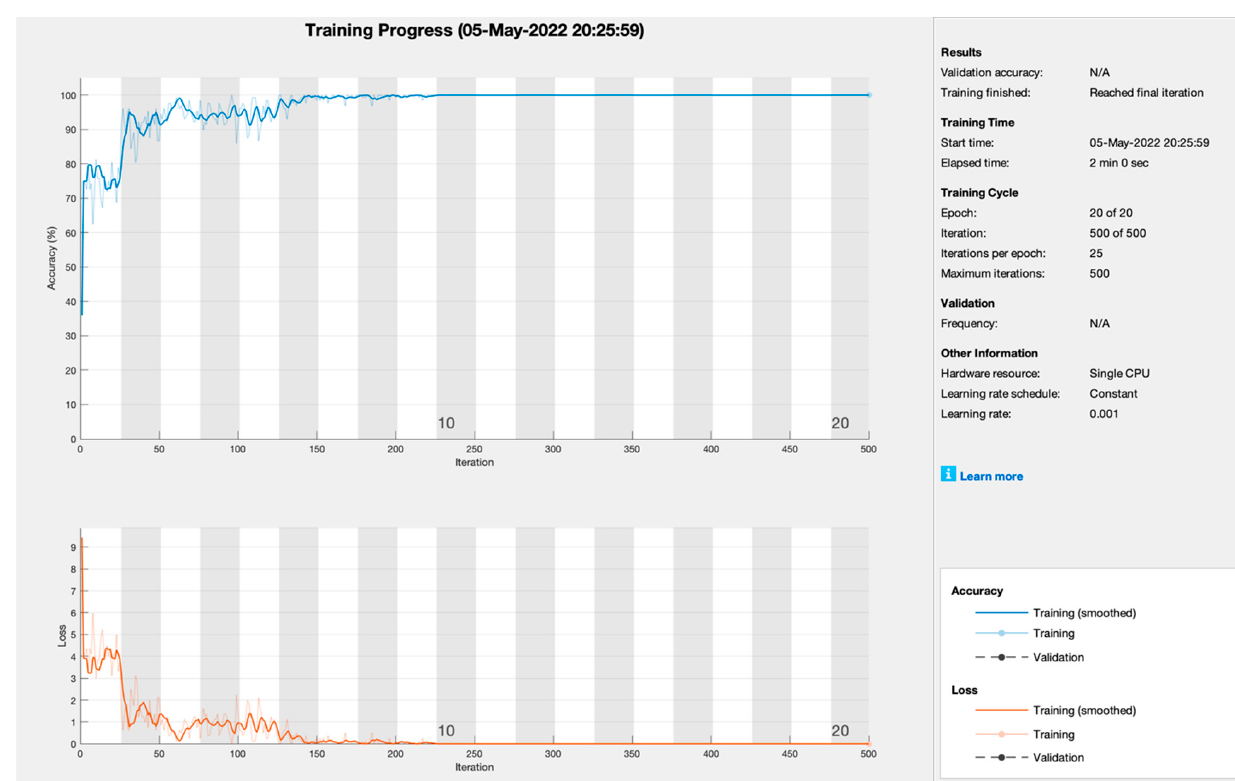
Figure 4. Training progress of SGDM empowered with AlexNet to predict kidney cancer.